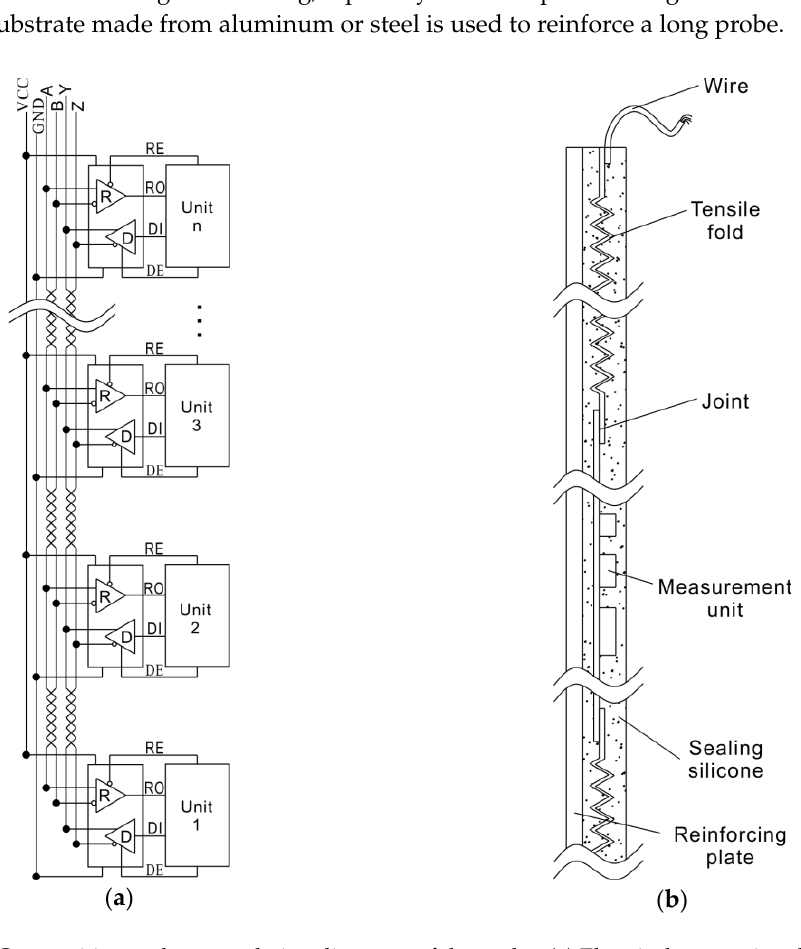
Figure 4. Composition and encapsulation diagrams of the probe: ( a ) Electrical connection diagram of the probe; ( b ) encapsulation structure diagram of the probe.